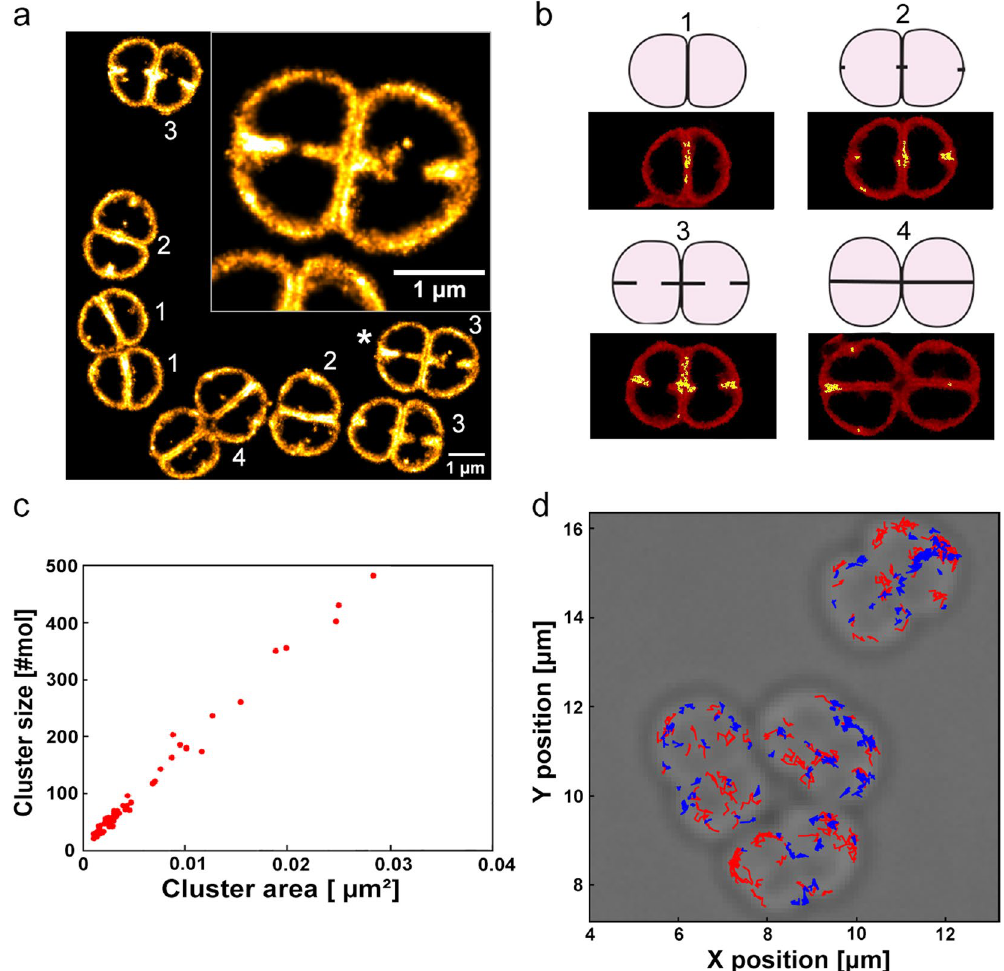
Figure 8. Cell division and septa formation in D. radiodurans . ( a ) Autoblinking-based PAINT image (15 ms frametime; 561 nm laser) of exponentially growing, live, unlabeled D. radiodurans cells. Bacteria are seen at different stages of their division cycle shown schematically in ( b ). Scale bar: 1 μ m. Inset: close-up view of a D. radiodurans diad (indicated with a * ) in which the double-layered cell wall separating the two bacteria can clearly be seen. ( b ) Schematic representations of D. radiodurans morphology along its cell cycle. Representative bacteria in each stage are shown in red as Voronoï diagrams following cluster analysis of the image shown in ( a ). Identified clusters are highlighted in yellow. ( c ) Number of autoblinking molecules per cluster as a function of cluster area. ( d ) Individual tracks of autoblinking molecules superimposed on the corresponding brightfield image. The faster and slower diffusing molecules are shown in red and blue